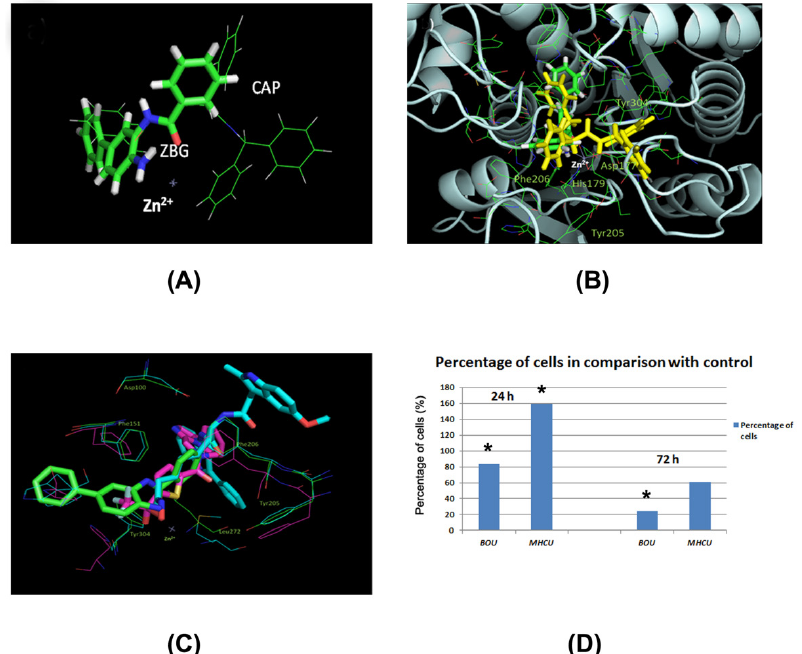
Figure 2. ( A ) The zinc- binding group (ZBG) and the CAP group of HDAC inhibitors ; ( B ) Suggested binding mode of N '-benzyloxyureido derivative BOU (yellow) within the crystal structure 3MAX of HDAC2 complexed with the benzamide LXX ( green); ( C ) Alignments of crystal structures of HDAC2 (3MAX, green), HDAC4 (2VQJ, pink) and HDAC8 (2V5X, cyan) complexed with the corresponding inhibitors; ( D ) HDA C enzymes (class I and/or II) activity in SW620 ce lls treated with BOU and MHCU for 24 and 72 h. Significant changes are marked with an asterisk ( *